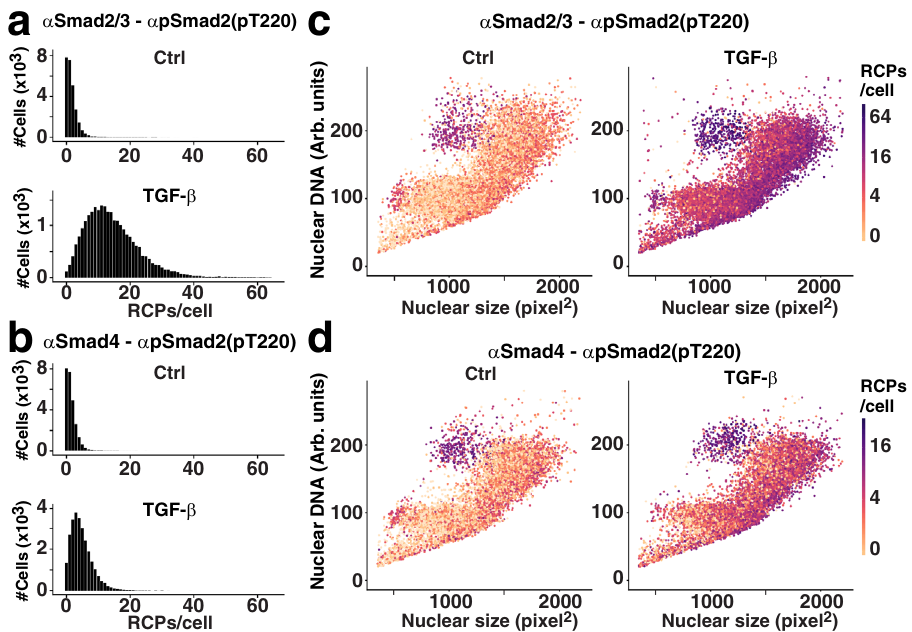
Fig. 2 Smad2 linker phosphorylation and complex formation in individual HaCAT cells, starved and untreated or treated with 10 ng/ml TGF- β for 60 min. a , b Results displayed as bar graphs according to the numbers of Smad2/3-Smad2(pT220) ( a ) or Smad4-Smad2(pT220) ( b ) RCPs/cell as categories along the X axes and with the height of the bars indicating the number of cells in each category according to the scale along the Y axes. The X axes were limited to display up to 65 RCPs/cell. c , d HaCaT cells, stimulated or not, were distributed in the plots according to the nuclear area of each cell along the X axes (pixels 2 (~0.11 µ m 2 )), and the integral intensity of the nuclear DNA stain along the Y axes. Numbers of Smad2/3-Smad2(pT220) ( c ) or Smad4-Smad2(pT220) ( d ) isPLA RCPs for individual cells were indicated by color scales. The log2 color scales indicate 0 – 96 RCPs/cell for c and 0 – 32 RCP/cell for d